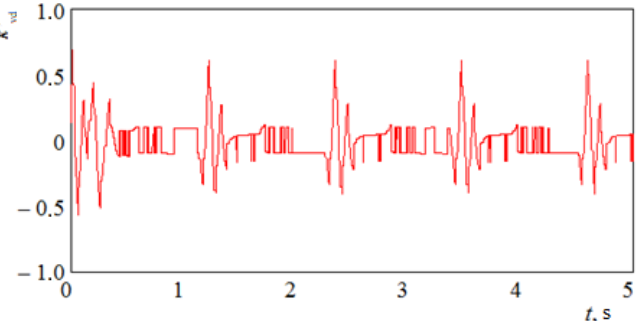
Figure 15. Forces in spring suspension.